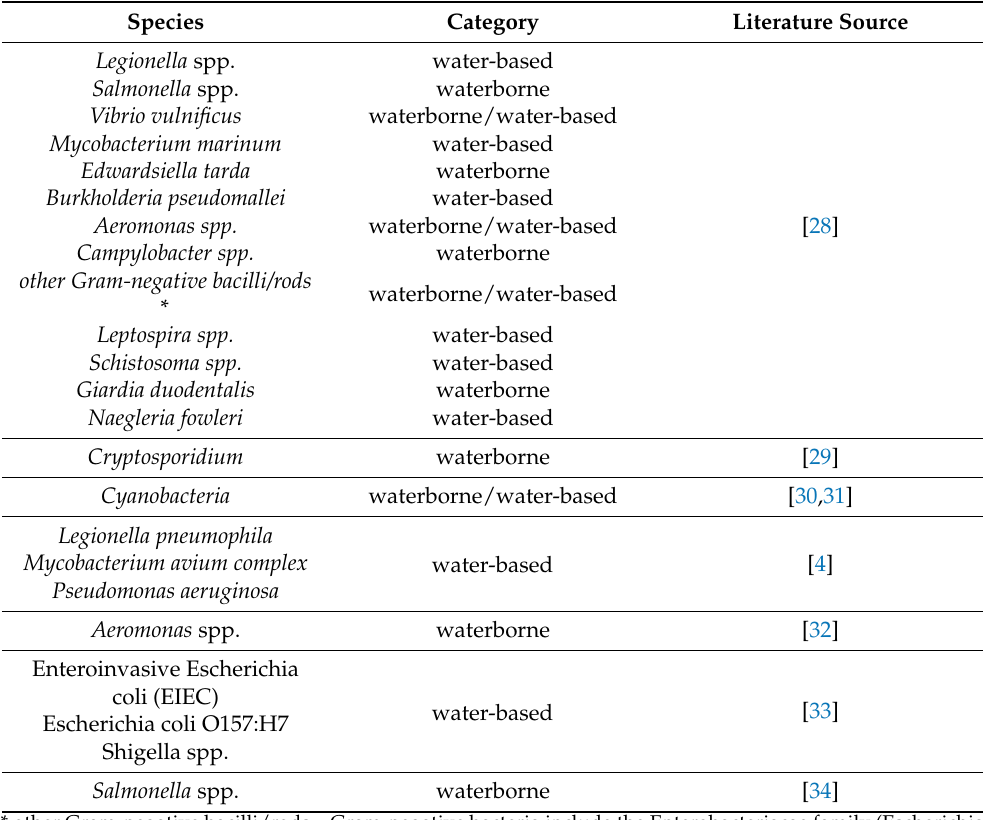
Table 1. Examples of pathogens found in recreational water on the basis of literature data.